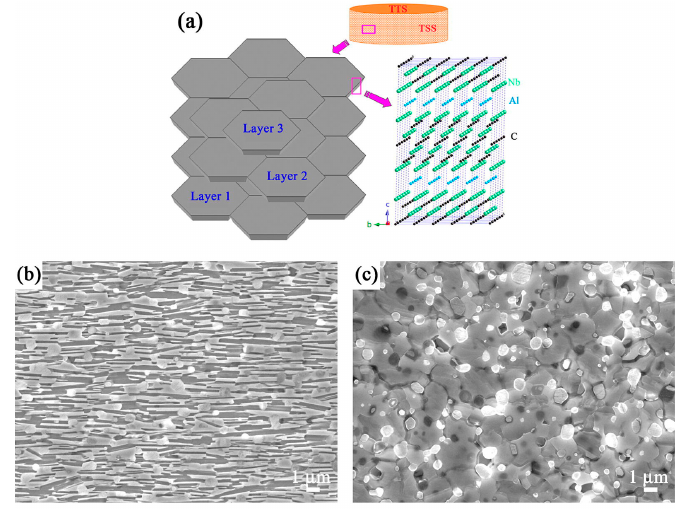
Figure 5. Cont. Figure 5.